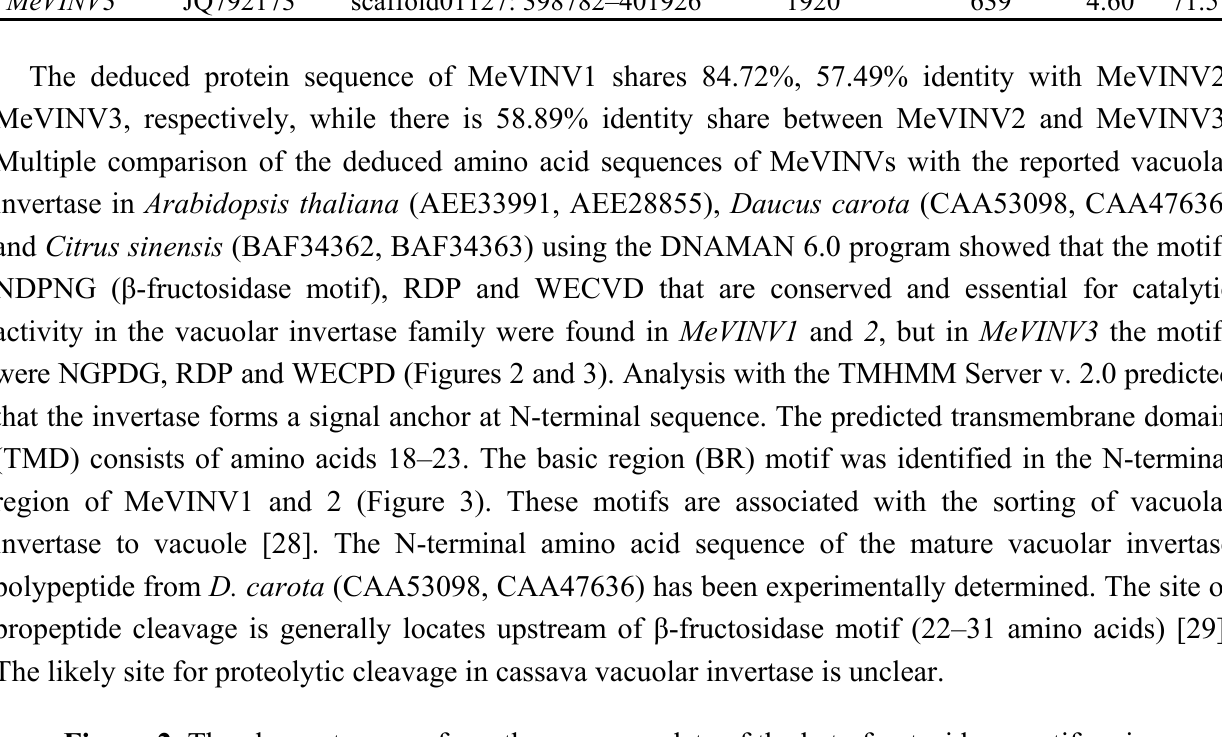
Figure 2. The chromatograms from the sequence data of the beta-fructosidase motif